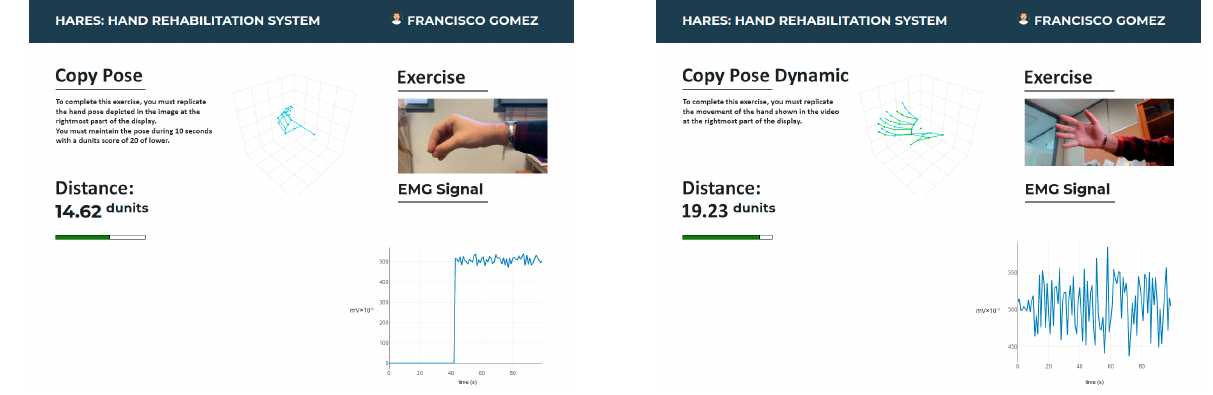
Figure 4. HaReS screenshots that correspond to a copy pose exercise (leftmost) and a copy pose dynamic exercise.